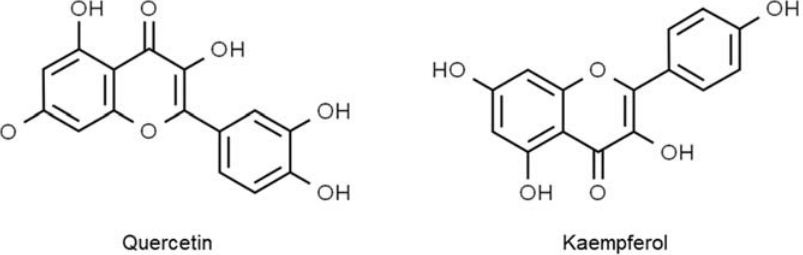
Figure 2. Polyphenolic compounds in okra seed.